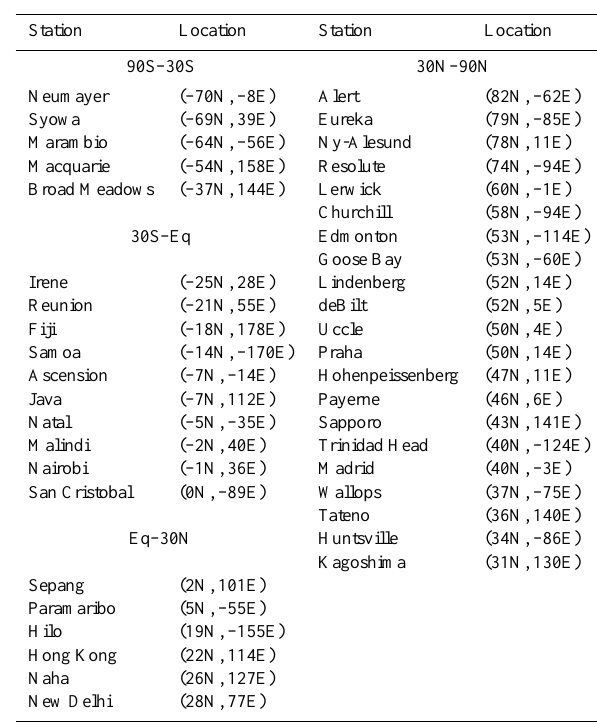
Table 11. Locations of ozonesondes used in Fig.